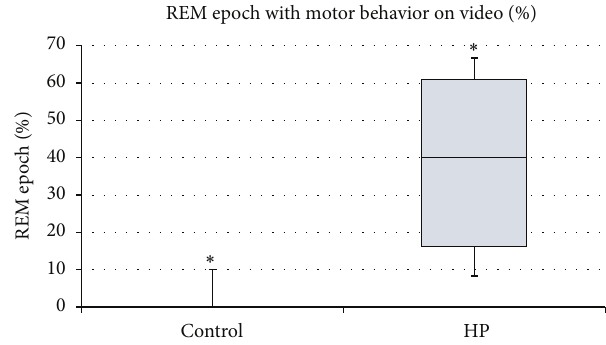
Figure 6: Percentage of REM epoch with motor behavior seen on video ( 𝑛 = 5 ) and HP ( 𝑛 = 5 ) groups. Motor behaviors included rhythmic head movements, sudden head movements, or sudden body movements that did not lead to arousal or wakefulness. Comparison of mean difference indicates a significant increase in movements observed on video during REM sleep in HP rats compared to control rats ( 𝑃 value